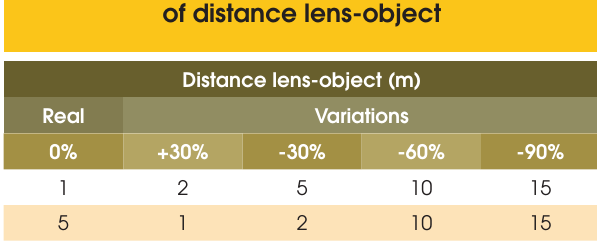
Table 4 – Real value and variations of relative